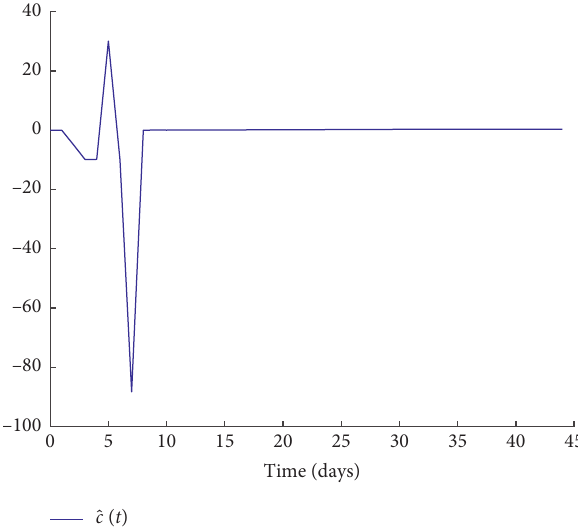
Figure 14: Estimation of β from filtered reported data (Italy).